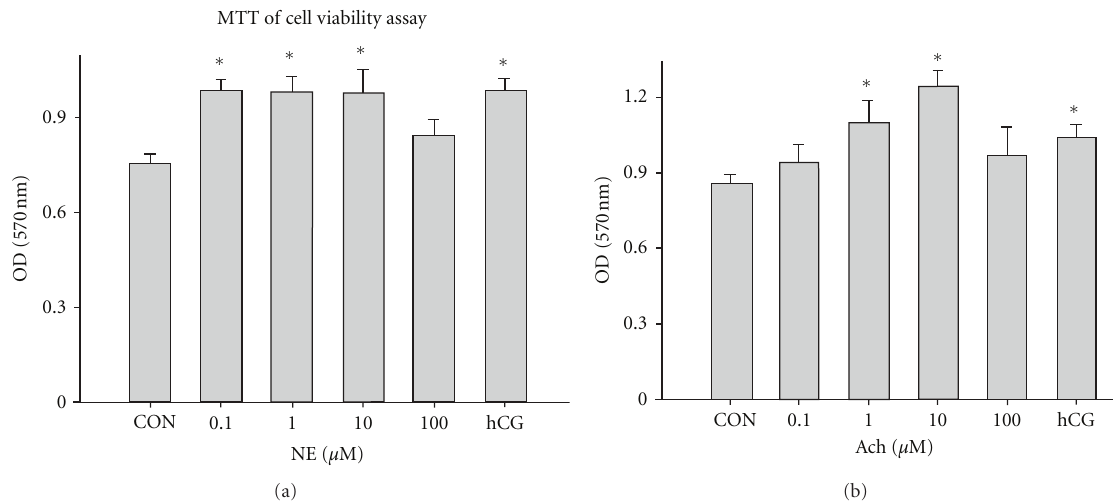
Figure 2: NE and Ach at doses of 0.1, 1, 10, and 100 μ M on the viability of Leydig cells from mice on PD15. The viability of Leydig cells incubated with di ff erent doses of NE and Ach for 24h was assessed using MTT assays. The data were presented as means ± SEM. A single asterisks ( ∗ ) indicates statistical significance ( P < 0 . 05) relative to the untreated control. CON: control group cultured with the same dilution of NE and Ach. hCG: hCG group cultured with hCG at the dose of 1IU/mL.